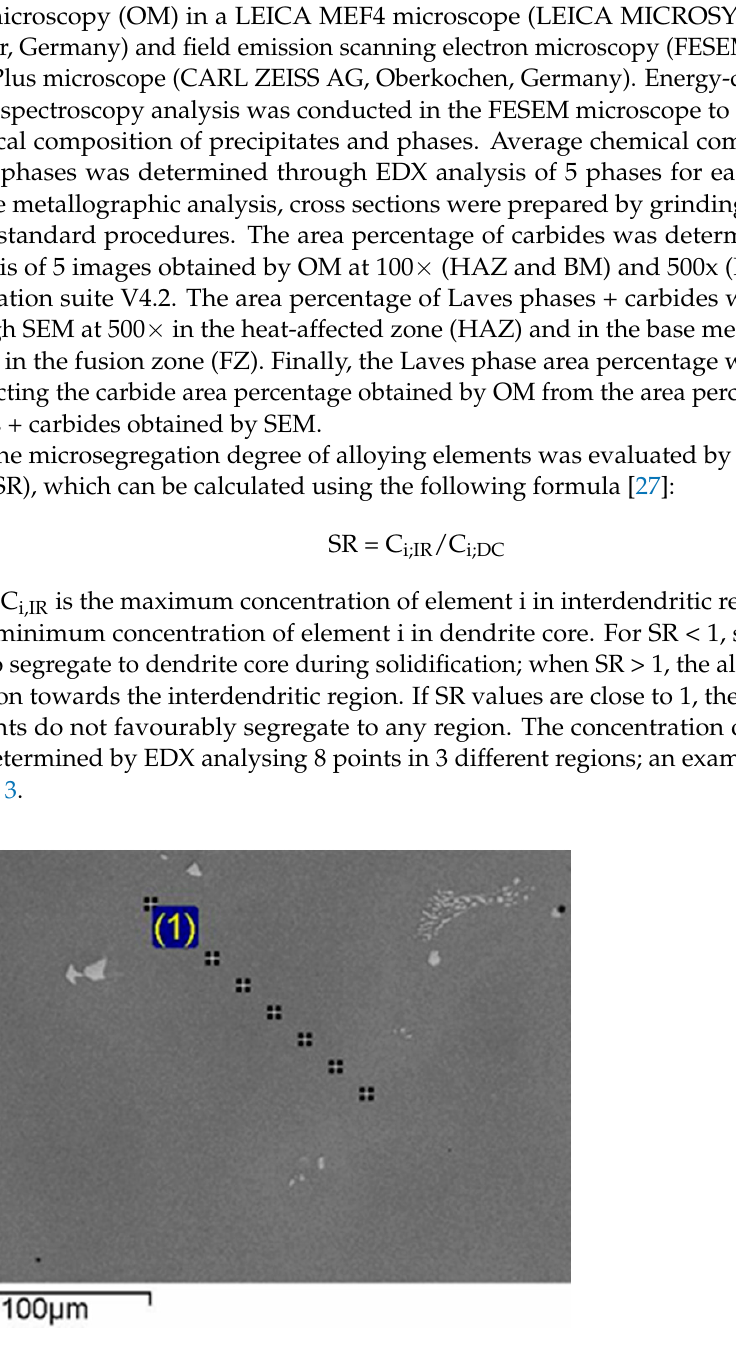
Figure 3. Location of EDX analysis points for determining the segregation ratio.